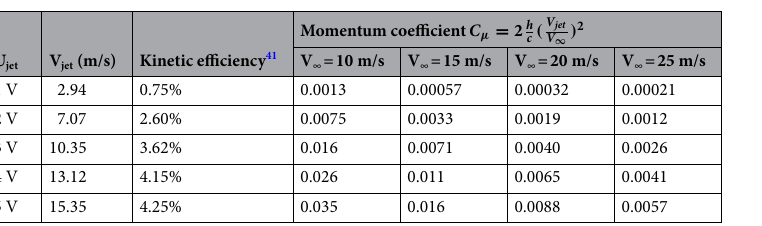
Figure 2. Jet mean velocity with different excitation frequency and voltage.